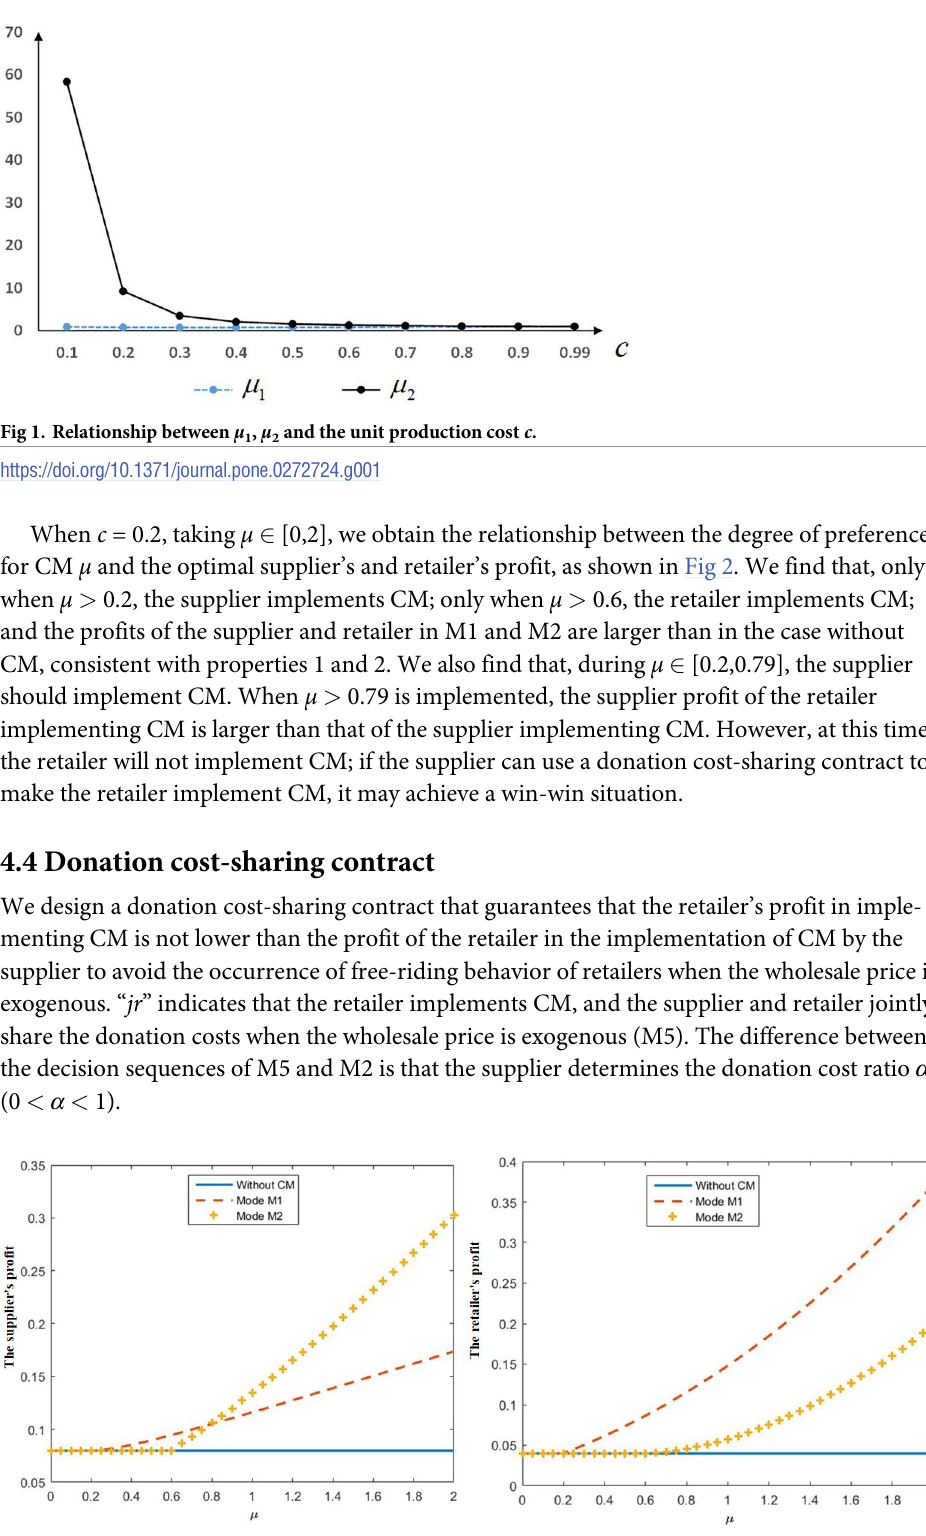
Fig 2. The influence of μ on the supplier’s profit and retailer’s